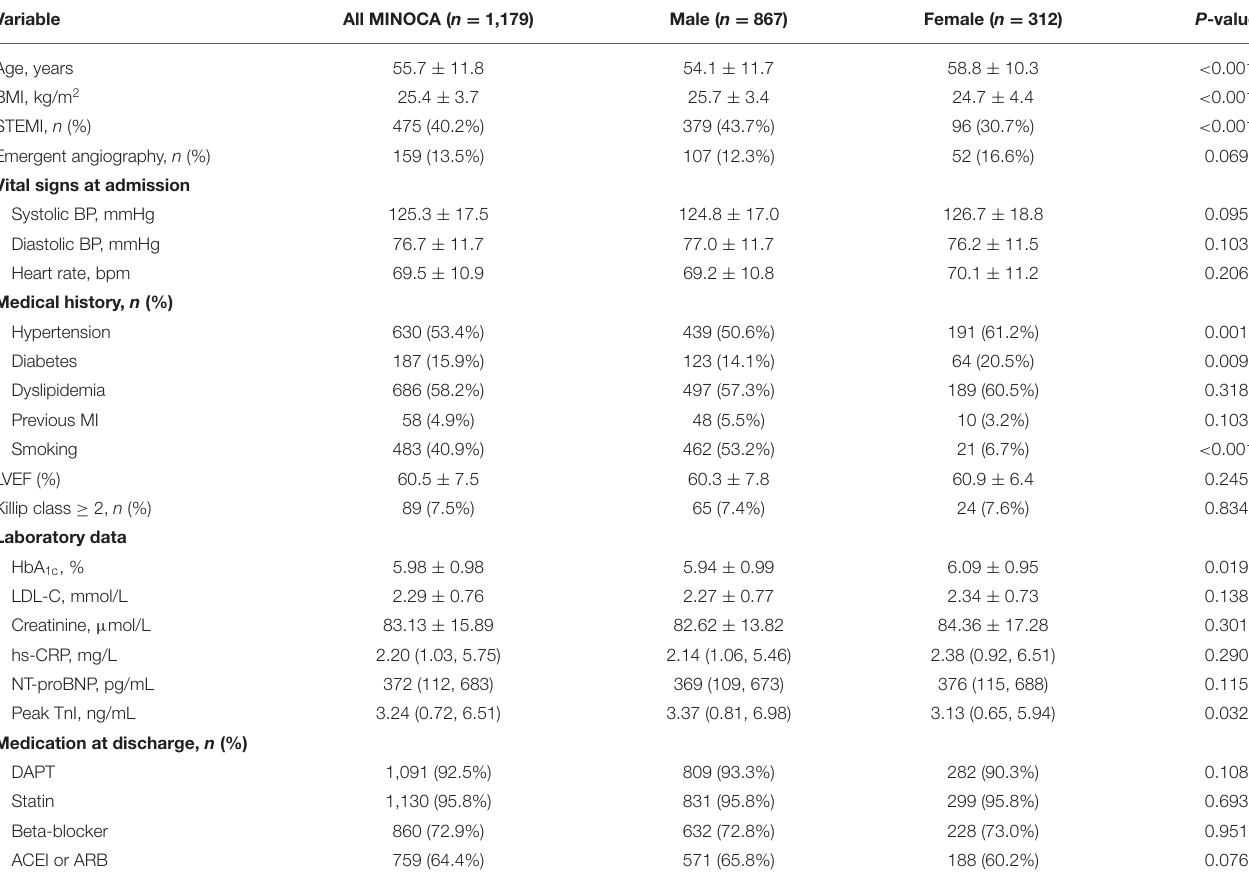
TABLE 1 | Baseline characteristics among male and female MINOCA patients. Variable